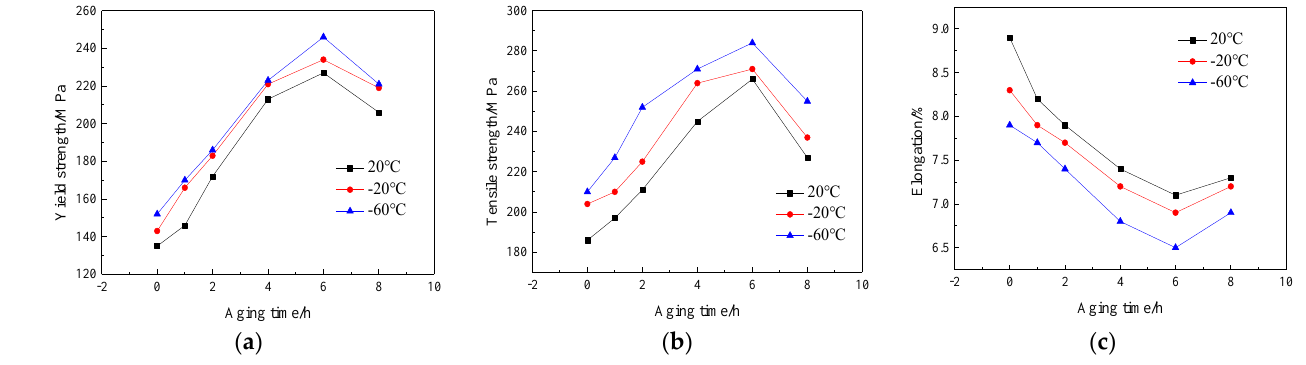
Figure 4. Low-temperature tensile properties of Al-7.0Si-0.3Mg alloy after different aging processes: ( a ) yield strength, ( b ) tensile strength, and ( c ) elongation. Mg is the most important alloying element in the Al-7.0Si-0.3Mg alloy. Mg and Si come from Mg 2 Si, which has a solubility of 1.85% in an α -Al solution at 595 °C [19]. Therefore, in Mg-containing Al–Si alloys, even the Mg 2 Si phase formed due to non-equilibrium solidification during the casting process dissolves into an α -Al solution at the appropriate temperature during the solid solution process. During the aging heat treatment, a large number of fine mass Mg 2 Si phases precipitated, which cause the alloy to significantly strengthen. Figure 5 shows the Si phase morphology near the tensile fracture of the as-cast Al-7.0Si-0.3Mg alloy and after 10h of the solution treatment at different experimental temperatures. By comparison with Figure 5a–d, it can be seen that the number of fractured Si phases near the fracture morphology of the as-cast Al-7.0Si-0.3Mg alloy and after 10 h of the solution treatment at 20 °C was relatively small. By comparison with Figure 5e–h, it can be seen that a large number of fractured Si phases appeared near the fracture surface of the as-cast Al-7.0Si-0.3Mg alloy and after 10 h of the solution treatment at −60 °C. By comparison with Figure 5a,b,e,f, the Si phase in the as-cast alloy structure was staggered and distributed in α -Al in the form of flakes or blocks. Near the grain boundary of the dendrite, a large number of dislocations were piled up in the α -Al dendrite during the stretching process, resulting in stress concentrating in the Si phase. Hence, the higher the stress, the more prone to the formation of fractures the large-area cleavage plane. By comparison with Figure 5c,d,g,h, after 10 h of the solution treatment, the structure of the Si phase was granularly distributed in the α -Al branch around the crystal. As the size of the Si phase reduced and it became more rounded, the dislocation stress received during the plastic deformation of the alloy was reduced. Therefore, it was not easy for the fracture to occur, which was an improvement of the tensile strength of the Al-7.0Si-0.3Mg alloy. Only small cracks were generated during the fracture. Hence, the fracture was dominated by dimples with small cleavage planes at the bottom, while the elongation of the Al-7.0Si-0.3Mg alloy was improved.